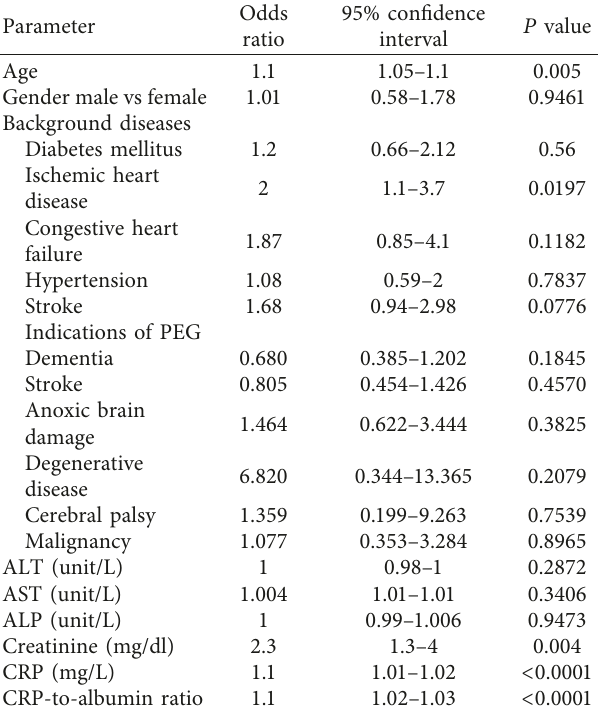
Table 4: Univariate analysis of parameters associated with short- term mortality.